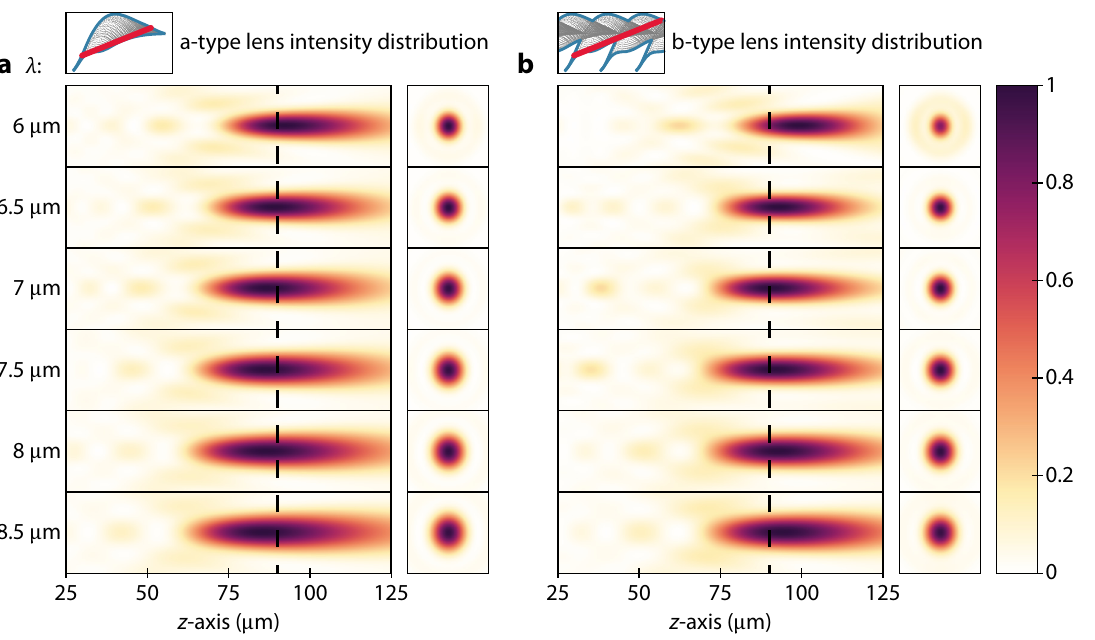
Figure 3: Intensity distributions and focal length shifts of metalenses in the wavelength range λ = 6 – 8.5 μ m. (a, b) Simulated normalized intensity distributions of the designed a- and b-type metalens, respectively, and their associated point spread functions at the target focal length of f = 90 μ